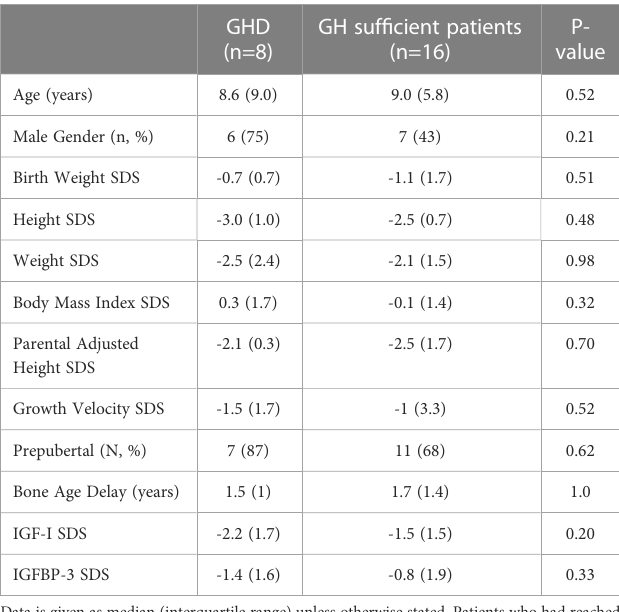
TABLE 1 Baseline characteristics of study